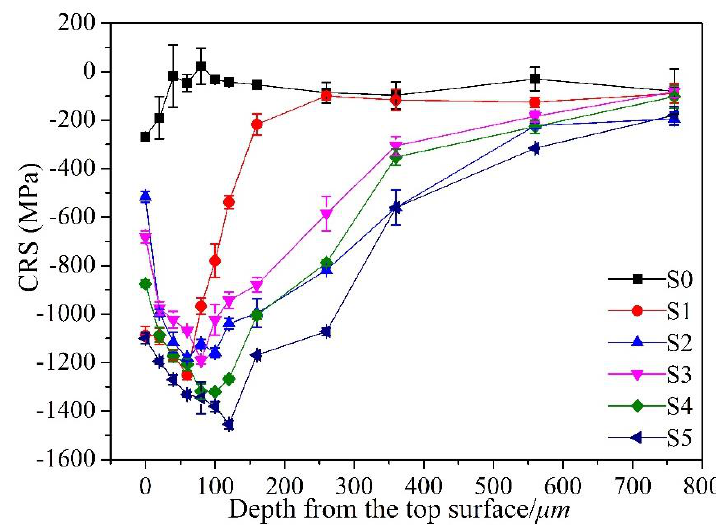
Figure 2. Depth profiles of the residual stress.